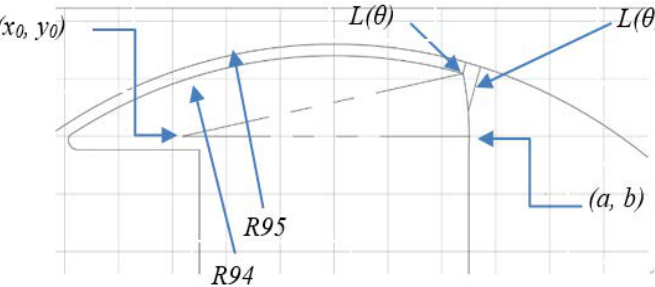
Figure 4. Analytical definition of Design 1.